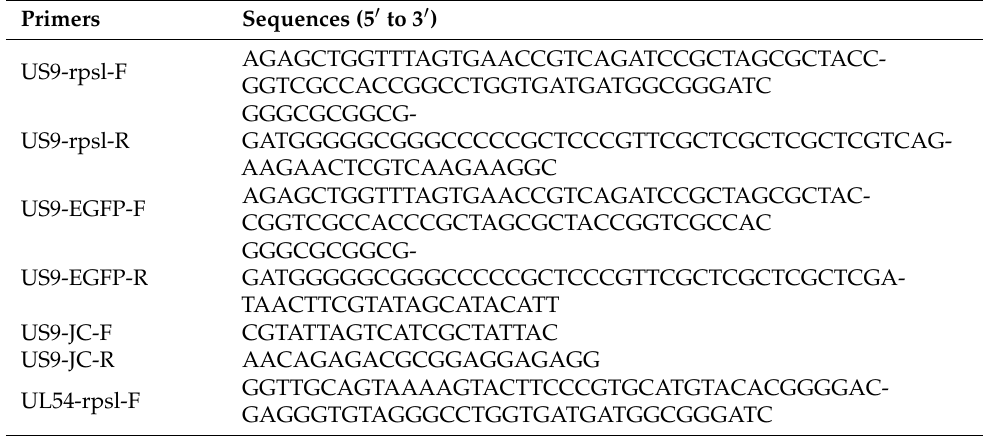
Table 1. Primers used to construct the recombinant pseudorabies